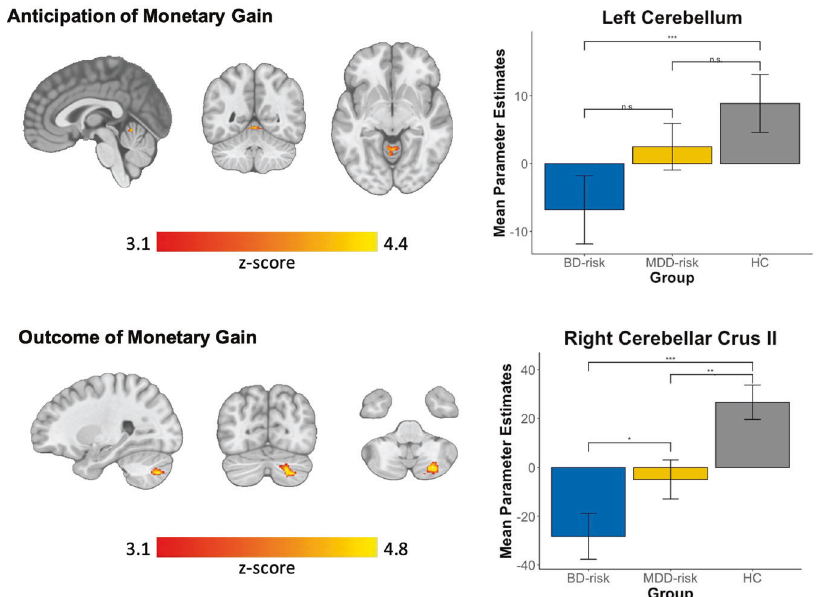
Fig. 2 Signi fi cant group differences within whole-brain clusters during reward processing. BD-risk had reduced activation in the left cerebellum compared with MDD-risk and HC during anticipation of monetary gain versus anticipation of no monetary gain. BD-risk had reduced activation in the right cerebellar crus II compared with MDD-risk and HC during outcome of monetary gain versus outcome of no monetary gain or loss. Z-statistics images were thresholded (Z > 3.1) using corrected-cluster signi fi cance threshold of p < 0.05. Legend: blue: BD-risk; yellow: MDD-risk; gray: HC. Left side of the image corresponds to the left hemisphere. Error bars are standard errors of the mean. n.s. = not signi fi cant; * p < 0.05, ** p < 0.01, *** p <